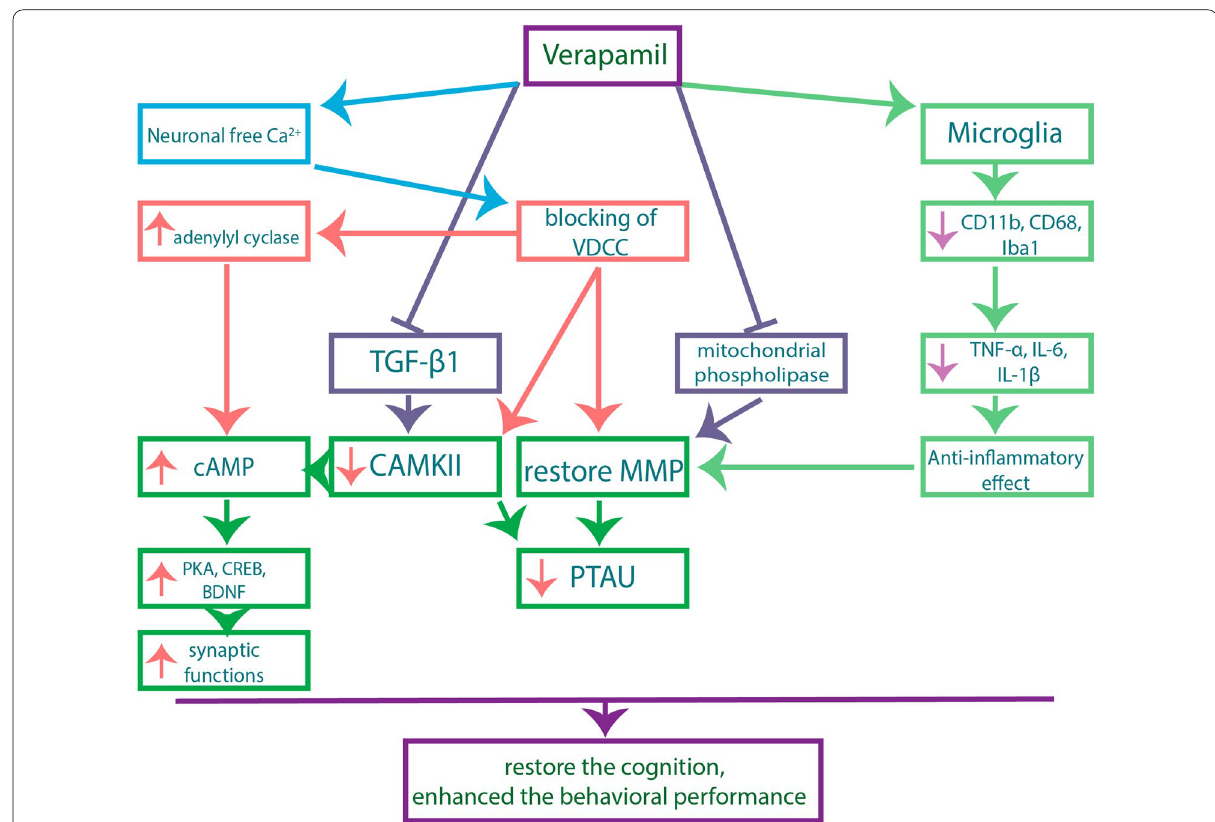
Fig. 12 Possible neuroprotective mechanisms of VRP. Iba1: ionized calcium-binding adaptor molecule 1, TNF-α: tumor necrosis factor-alpha, IL-6: interleukin-6, IL-1β: interleukin 1β, TGF-β1: transforming growth factor beta 1, VDCC: voltage-dependent calcium channel, MMP: mitochondrial membrane potential, PTAU: phosphorylated tau protein, CAMKII: Ca 2 + / calmodulin dependent kinase II, PKA: protein kinase A, cAMP: cyclic adenosine monophosphate, CREB: cAMP response element-binding protein, BDNF: brain-derived neurotrophic